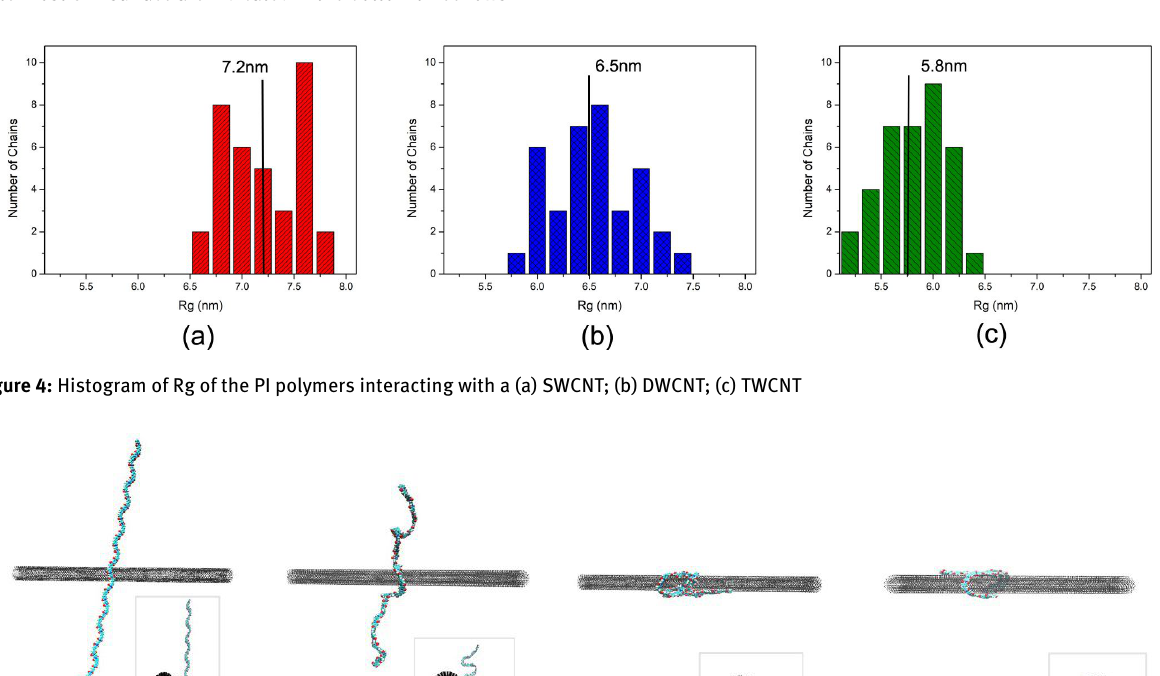
Figure 3: Snapshots from final step of the MD simulation trajectory of multiple PI chains, colored by chain, interacting with a (a) SWCNT; (b) DWCNT; (c) TWCNT. The upper and bottom two rows are depicting two different sides of the CNT. Note, that only atoms within 0.7 nm of the outermost CNT surface are indicated in the bottom three rows